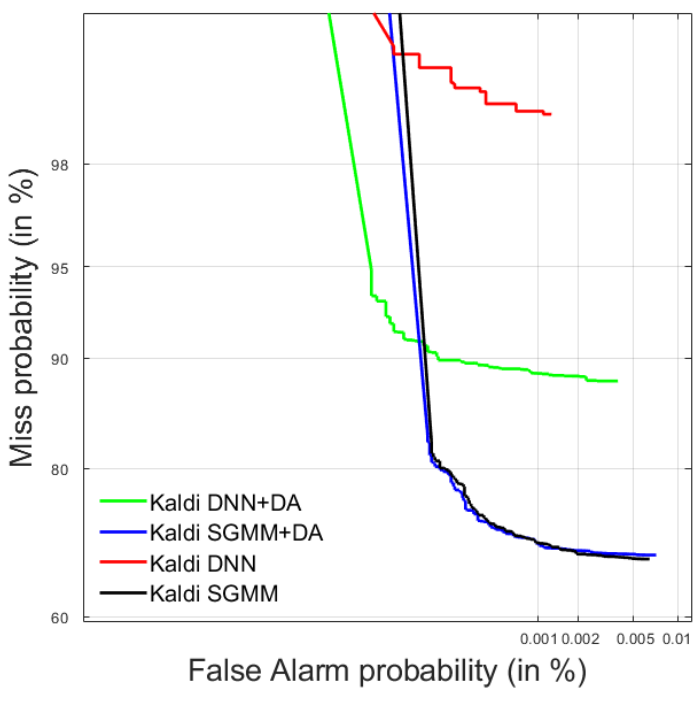
Figure 4. DET curves of the STD systems for RTVE development data.